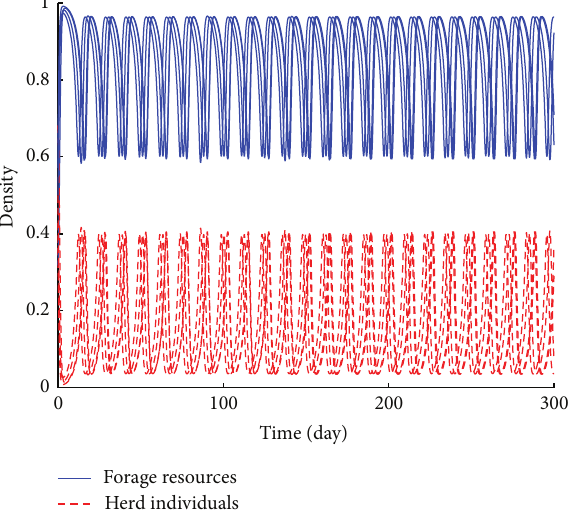
Figure9:Phaseportraitcorrespondingtothedisappearingofforage resources and water resources and removal of the pastoralists with theirherdsforSystem(2).Wecanobserveheretheglobalasymptotic stability of 𝐸 10 = (0, 0,0) when 𝑟 1 = −0.4 < 0 and 𝑟 2 = −60 < 0 . The rest of parameters are in Tables 1 and